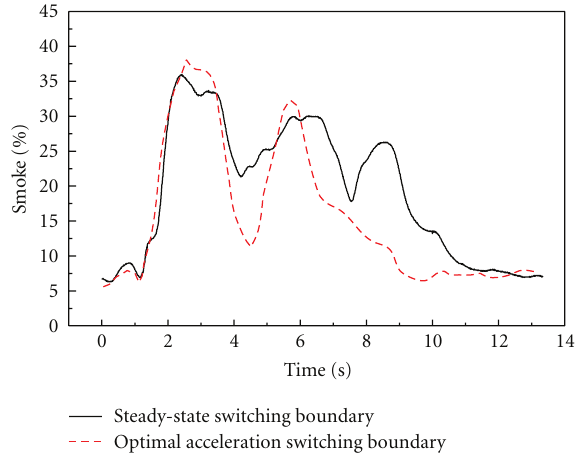
Figure 14: Smoke comparison of two ST strategies in the accelera- tion process from 900 to 2100r/min at 600 N ·